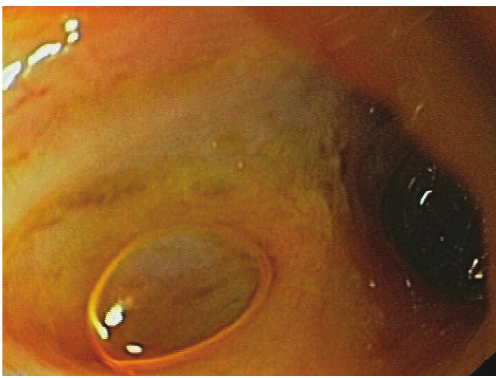
Figure 1: The biliodigestive anastomosis is endoscopically visual- ized.